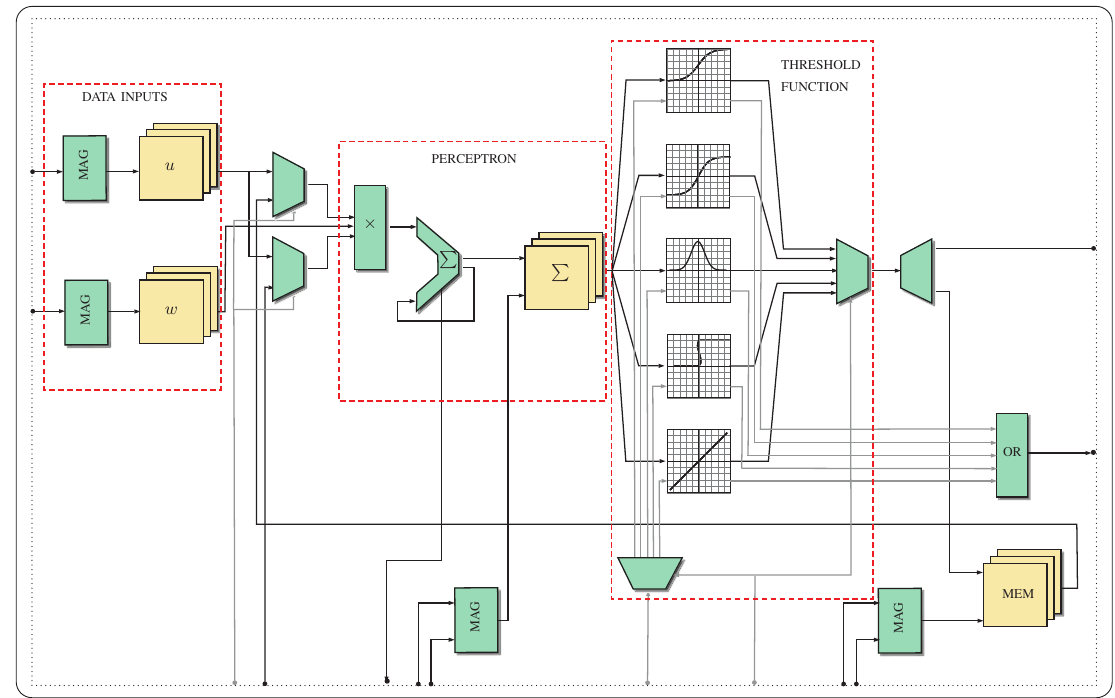
Figure 4. Hardware contained in Datapath